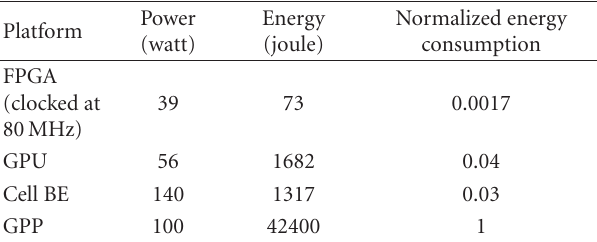
Table 9: Power and energy consumption of the Smith-Waterman algorithm implementation on all four technologies.